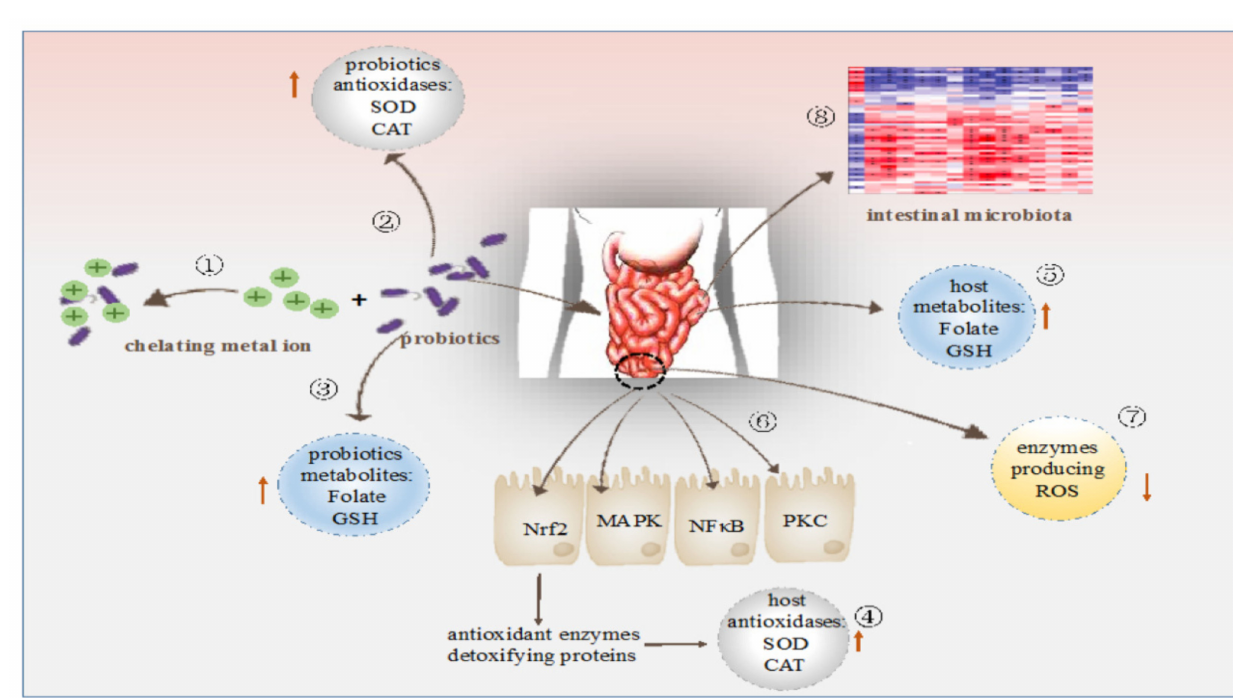
Figure 2. Modulation of antioxidation by probiotics: (1) Chelate metal ions. (2) Possessing their own antioxidation system. (3) Production of antioxidant metabolites. (4) Up-regulation of antioxidant activities of the host. (5) Alleviating the levels of antioxidant metabolites of the host. (6) Regulating signaling pathways. (7) Down-regulation of activities of enzymes producing ROS. (8) Regulation of intestinal microbiota. Adopted from